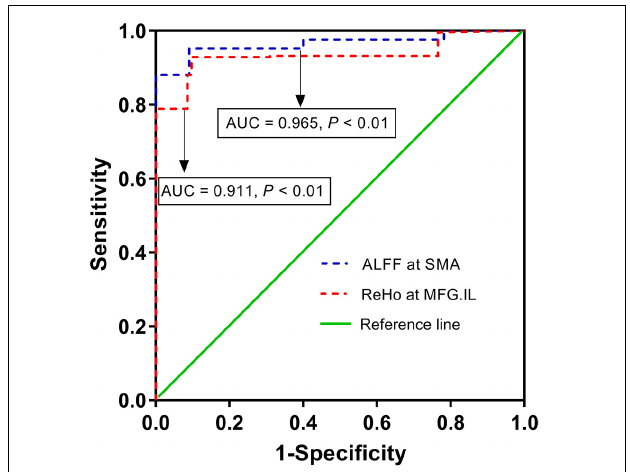
FIGURE 4 | The diagnostic performance of altered dynamic ALFF in SMA and dynamic ReHo in ipsilesional MFG in distinguishing stroke patients from healthy subjects. ALFF, amplitude of low-frequency fluctuation; ReHo, regional homogeneity; SMA, supplementary motor area; MFG, middle frontal gyrus; IL, ipsilesional; AUC, area under curve.